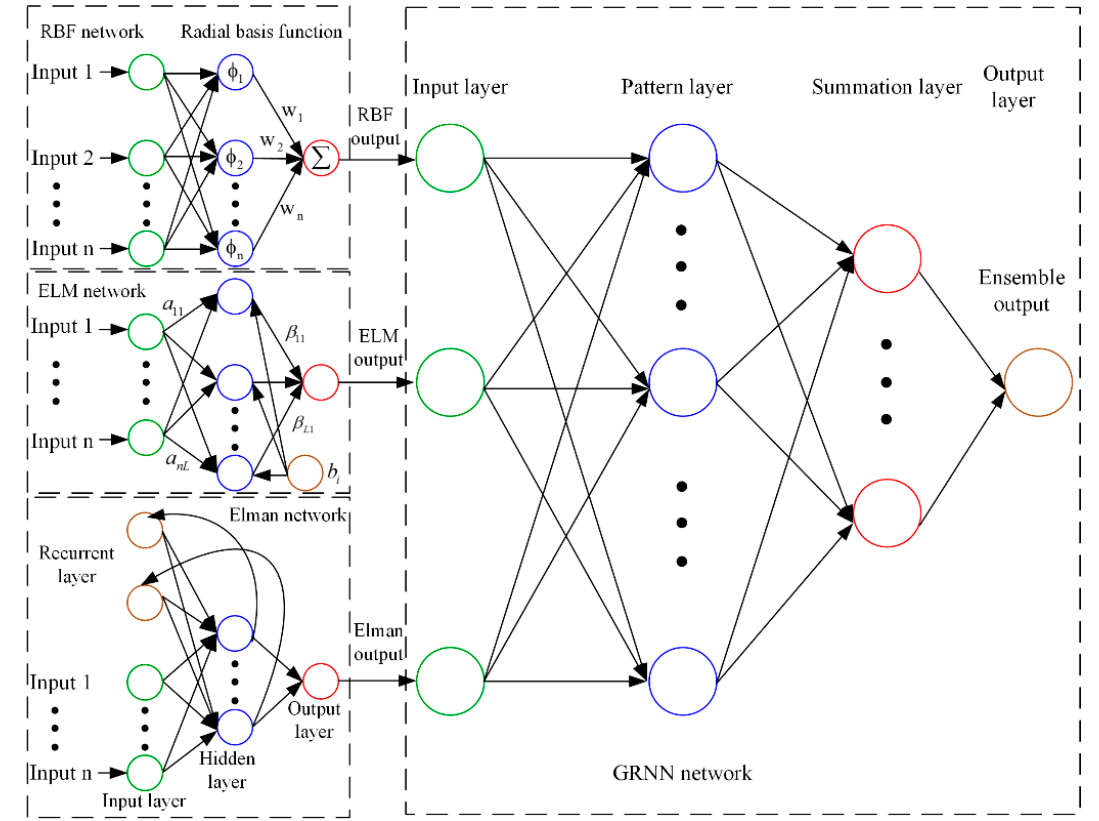
Figure 1. The structure of the GNE model based on RRF, ELM and Elman networks.